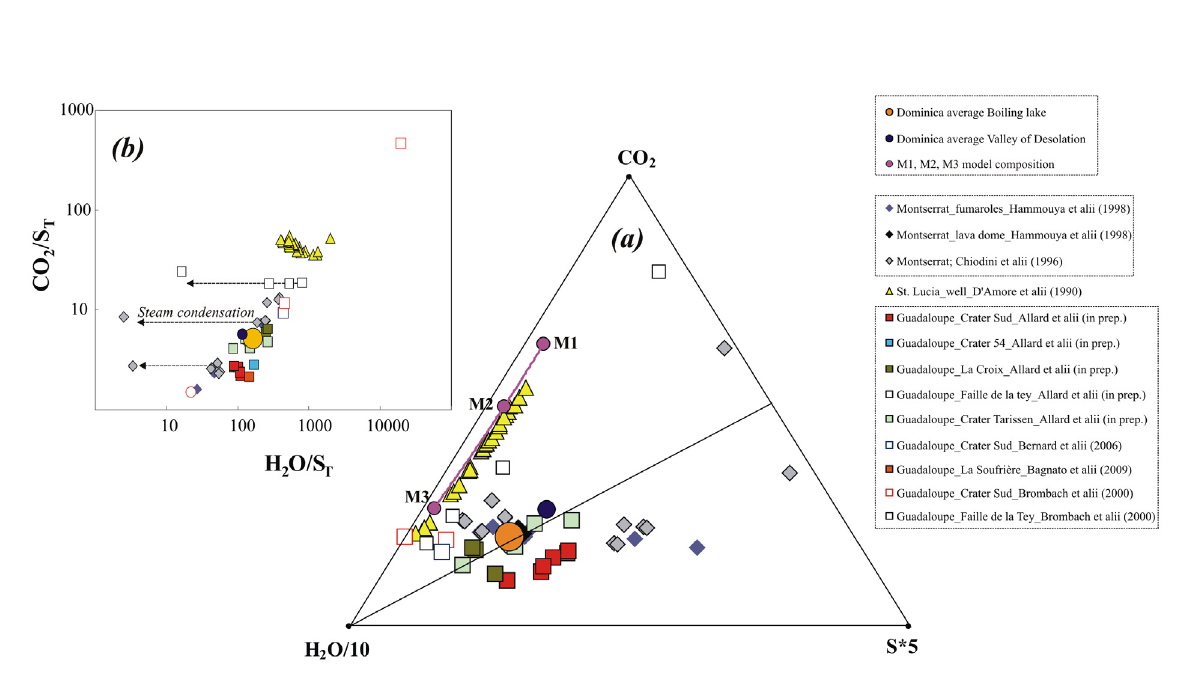
Figure 6. (a) A triangular plot putting the BL gas in the context of previous gas observations in the Lesser Antilles (see legend for references). Com- positions for VoD and BL gases were obtained from the best-fit gas/gas ratios (e.g., from the slopes of the best-fit regression lines in Figure 5). The diagram also shows the compositions of M1-M3 model gases, obtained by EQ3/6 model simulations of gas lake-water interaction (scrub- /S vs. H O/S ratios. The Boiling Lake gas sits in the median portion of the Lesser Antilles’ gas bing); (b) Scatter plot of CO 2 T 2 T